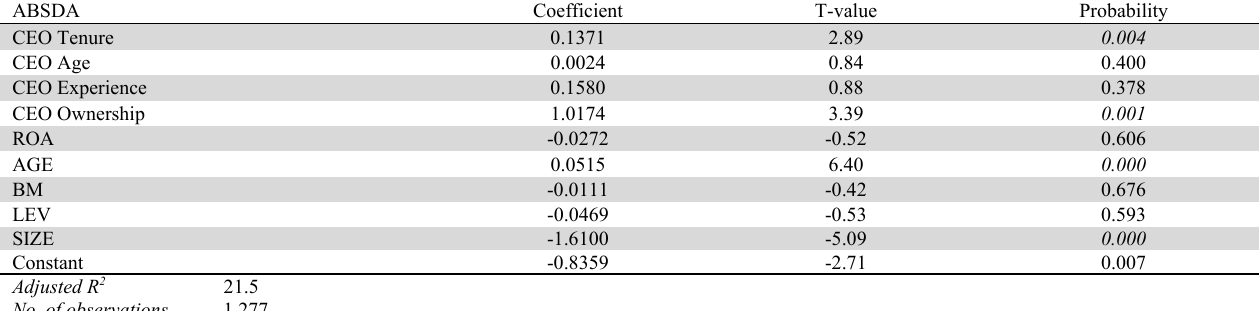
Regression results of the association between CEO characteristics and